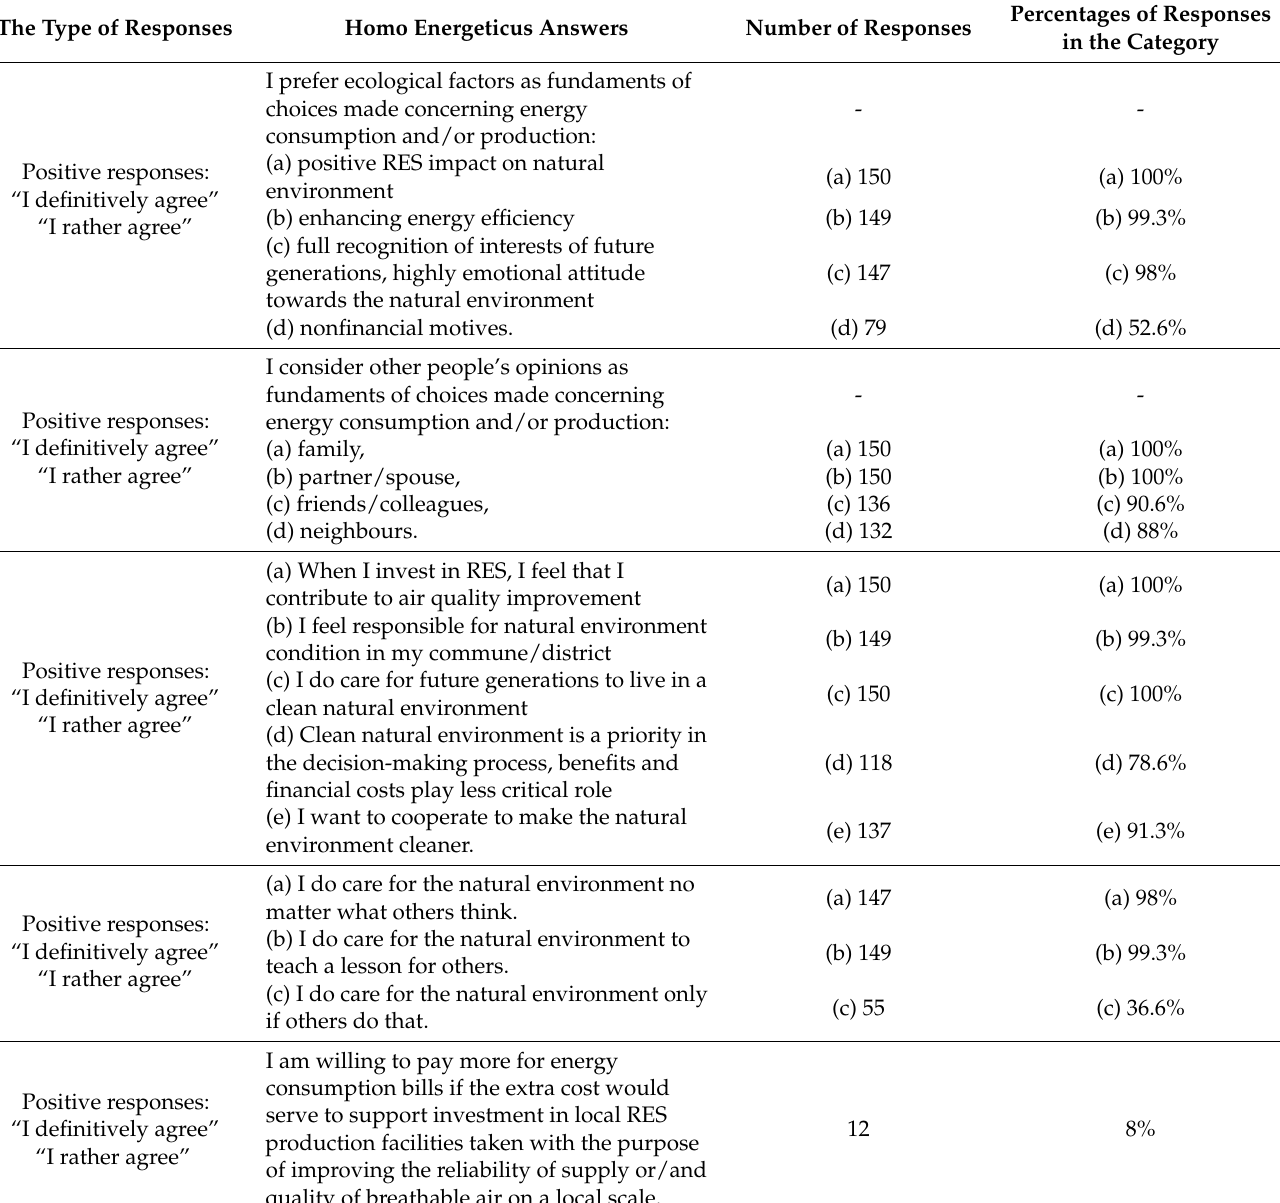
Table 7. Aggregate statistics and percentages of responses provided by homo